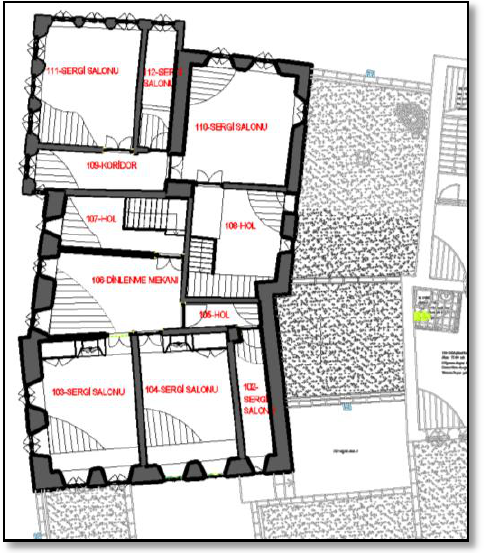
Figure 14. Restoration Project- 1st floor-Spaces of Museum